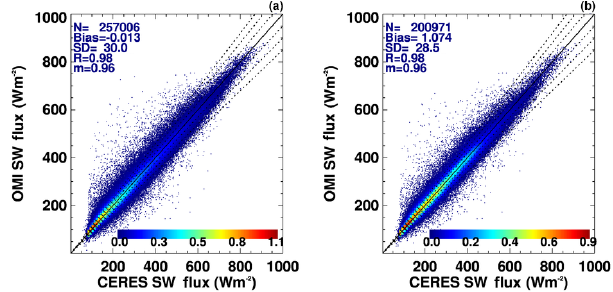
Figure 5. Two-dimensional histograms (similar to Fig. 2) of daily mean CERES- and OMI-derived (NN) TOA SW flux for Jan- uary 2007: (a) the NN is trained on and applied to data from Jan- uary 2007 and compared with CERES data from that month and (b) the NN is trained using data from January 2007 and applied with input data from January 2006 and compared with CERES data from January 2006. The color bar shows sample density (in frac- tional (percent) amount) of the collocated data set (see text for more details). The three dotted lines are 5, 10, and 15% error envelope